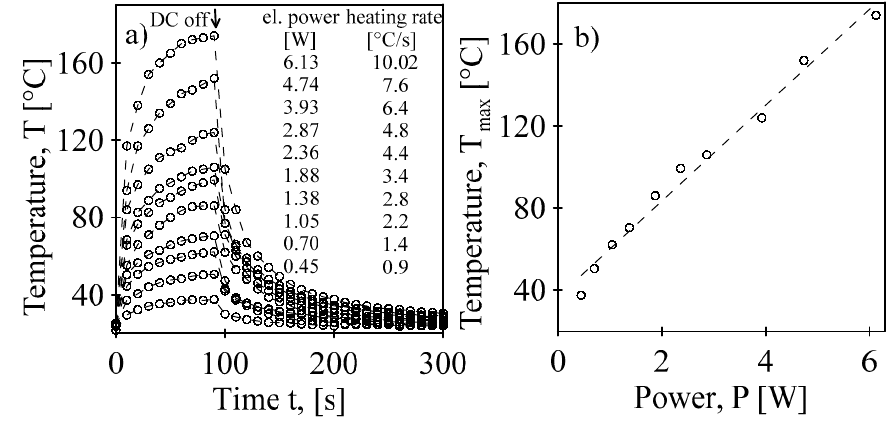
Figure 1. a ) Temperature progression of the MWCNT nanopaper through Joule heating at different Figure 1. ( a ) Temperature progression of the MWCNT nanopaper through Joule heating at di ff erent electrical power rates and an initial heating rate. b ) The dependence of the reached maximal electrical power rates and an initial heating rate. ( b ) The dependence of the reached maximal temperature on the applied DC electrical power through Joule temperature on the applied DC electrical power through Joule heating.